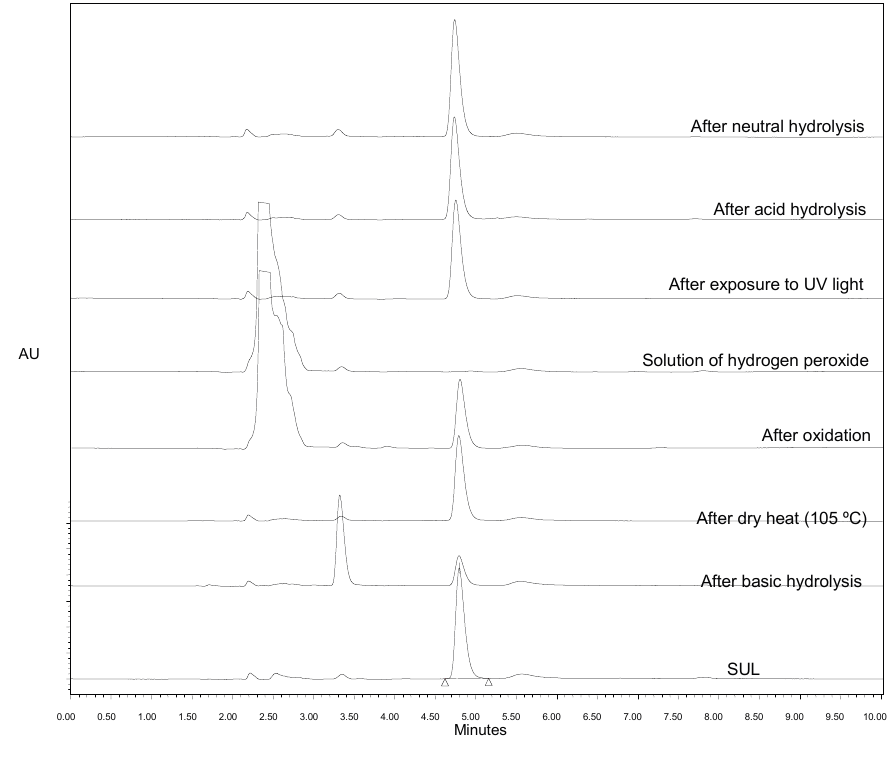
Figure 1. Chromatograms of sulfentrazone (SUL) before (standard) and after subjection to stress by exposure to dry heat, exposure to UV light, oxidation, neutral hydrolysis, acid and basic hydrolyses and hydrogen peroxide solution.